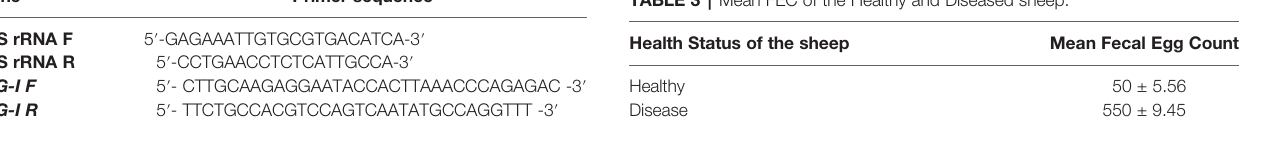
TABLE 3 | Mean FEC of the Healthy and Diseased